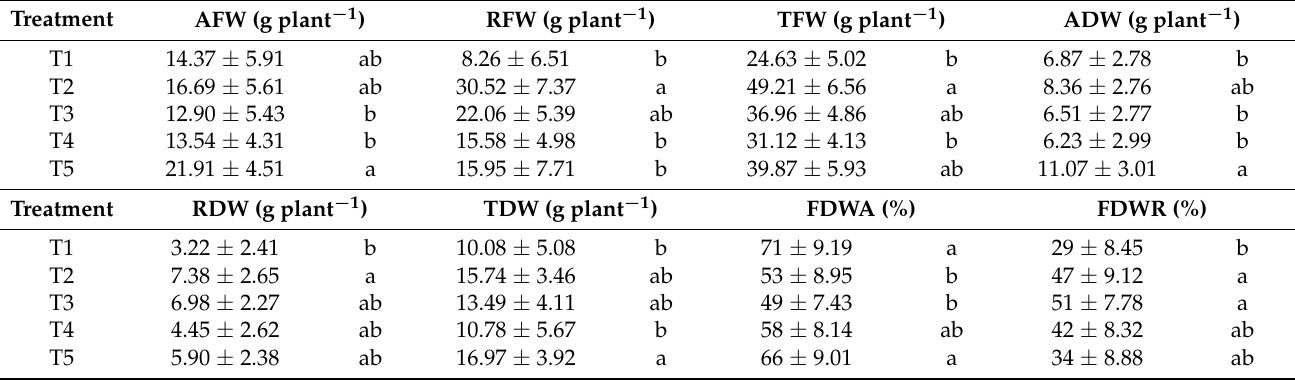
Table 7. Values at DOY 327 of fresh and dry weight allocated in the above ground part and in the roots of blueberry plants cv Duke grown on substrates with different percentage of peat and compost from solid digestate and grapevine pruning woods. Means followed by the same letter do not significantly differ at p < 0.05. Data are reported as mean values ( n = 12) ±